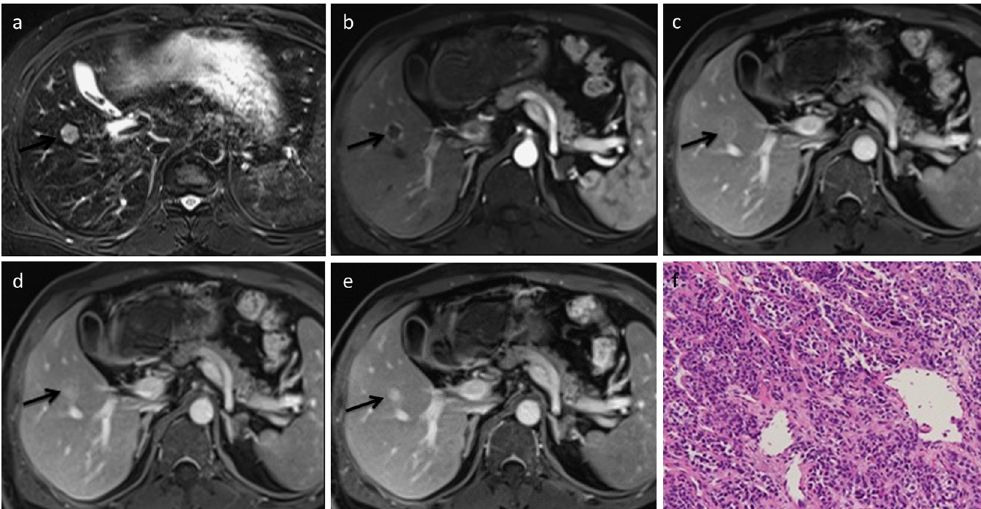
Figure 1. Peripheral nodule cholangiocarcinoma in a 68-year-old man. ( a ) MRI of the nodule in segment V, approximately 17 mm in diameter, by transverse T2WI; the nodule is slightly hyperintense relative to that of the liver parenchyma. ( b ) The arterial phase shows that the nodule has no hyperintense portion compared with that of the liver parenchyma except for peripheral rim-like enhancement. ( c ) Enhanced area/nodule size > 2/3 in the portal phase. ( d , e ) Delayed phase (3 and 5 min) images clearly demonstrate cloud-like contrast filling with a low-SI peripheral rim. ( f ) Histological examination was diagnostic of cholangiocarcinoma (hematoxylin and eosin-stained section; original magnification, 200 × ).